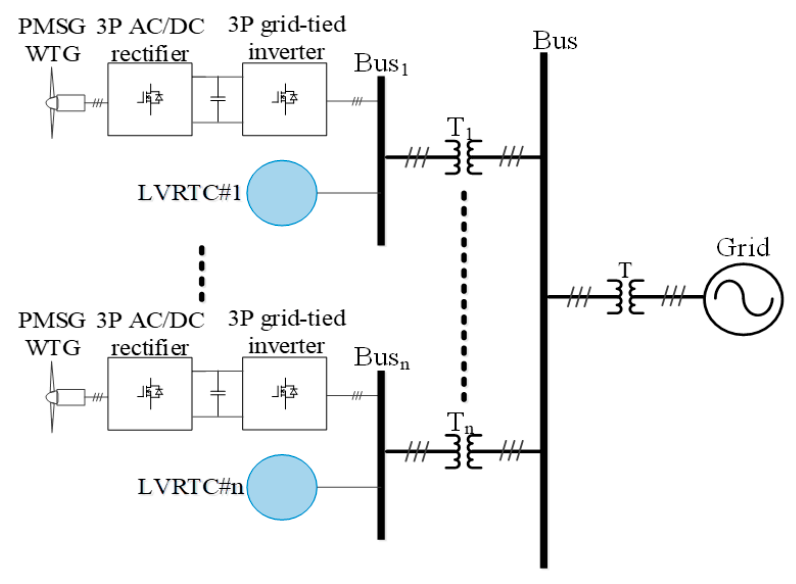
Figure 3. Conceptual WTG schematic architecture and allocation of the proposed LVRTC.